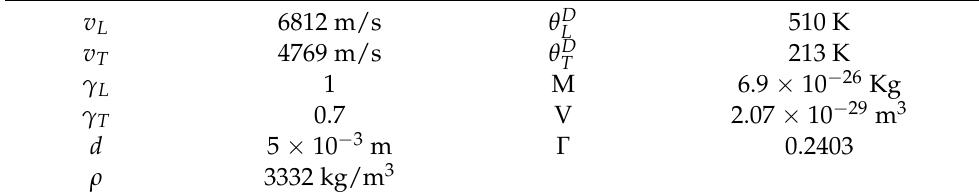
Table 3. Physical parameters for Si 0.7 Ge 0.3